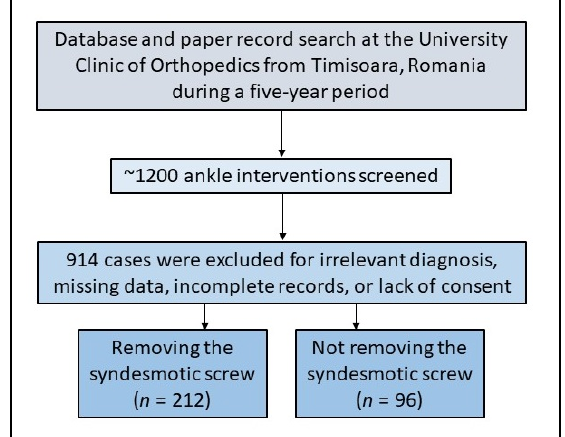
Figure 1. Flowchart displaying cases included in the current study.